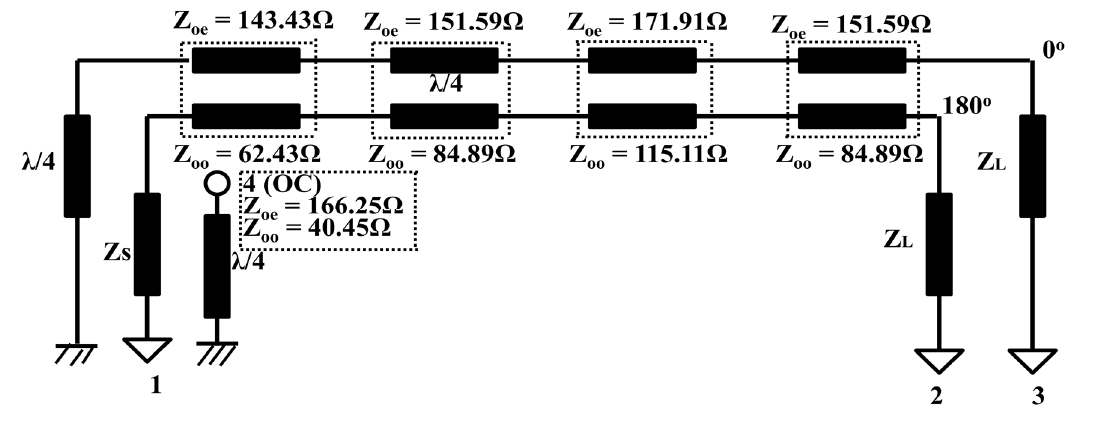
Figure 2. Schematic of the proposed wideband multi-section coupled-line